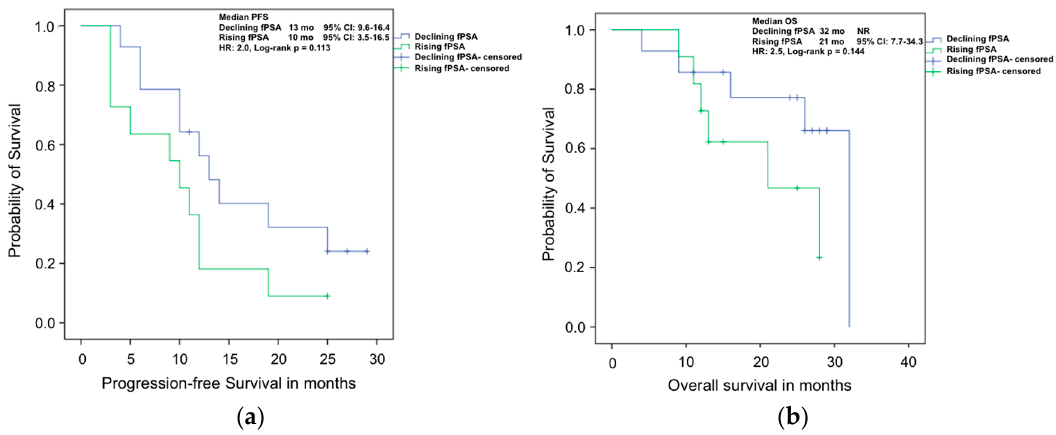
Figure 2. Kaplan–Meier analyses of ( a ) progression free survival; and ( b ) overall survival of mCRPC patients treated with Abiraterone with rising or declining fPSA values after 8–12 weeks of therapy.